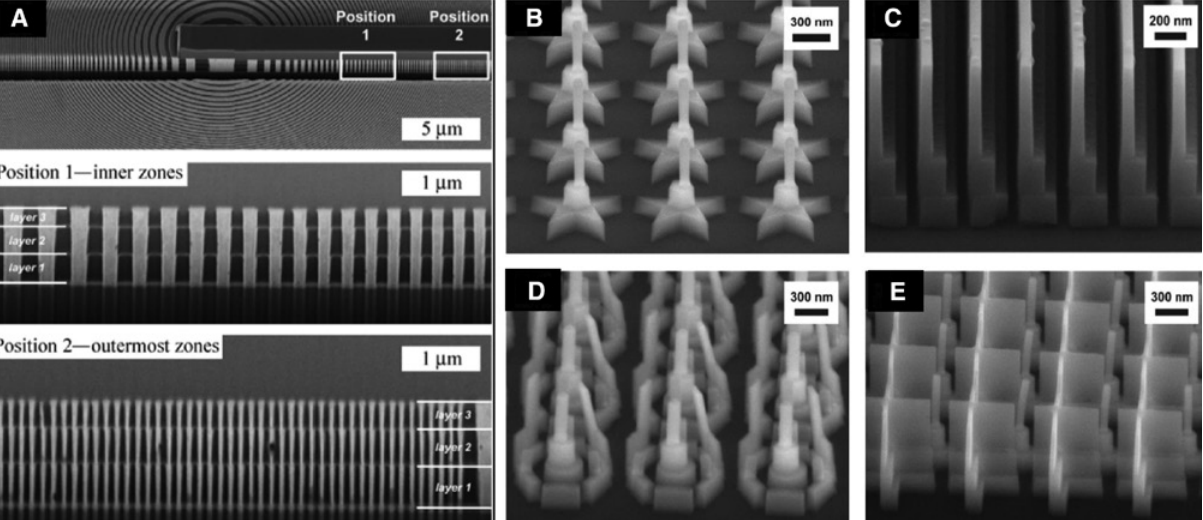
Figure 1: SEM images of structures obtained via overlay exposures: (A) a stacked zone plate made by electroplating [50], (B−E) examples of arbitrary shaped 3D HSQ structures